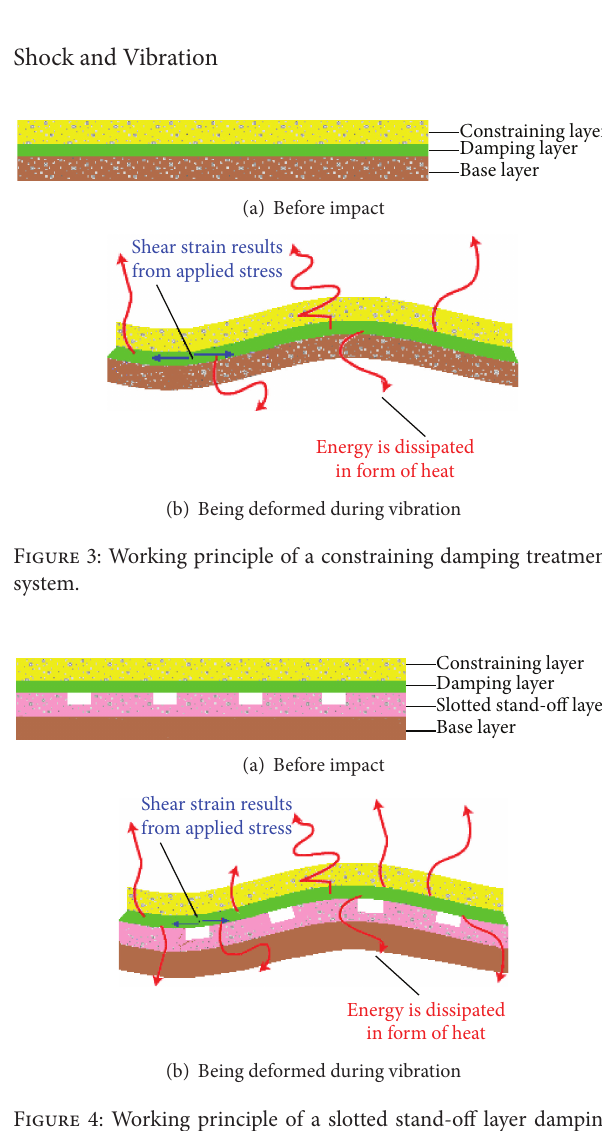
Figure 4: Working principle of a slotted stand-off layer damping treatment.